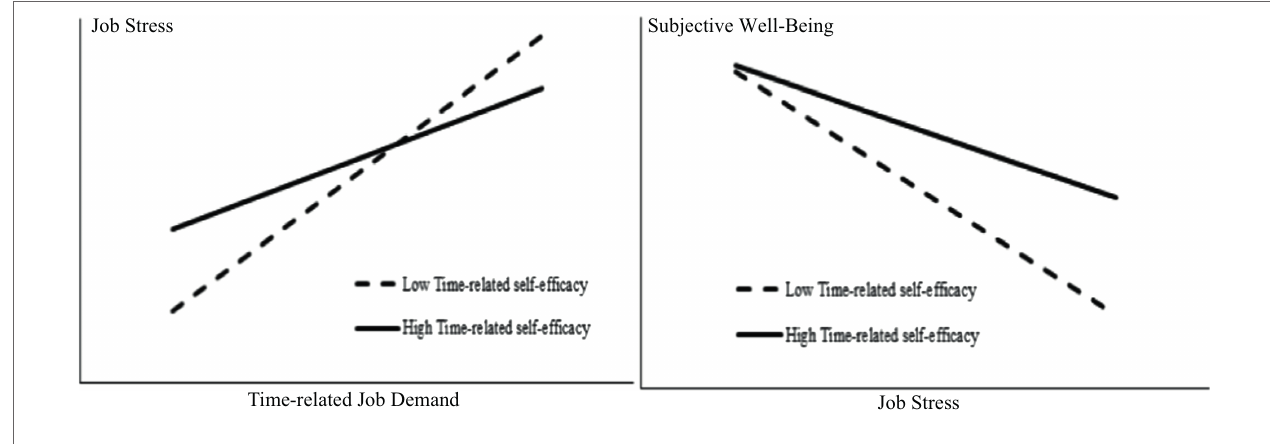
FIGURE 3 | Interaction